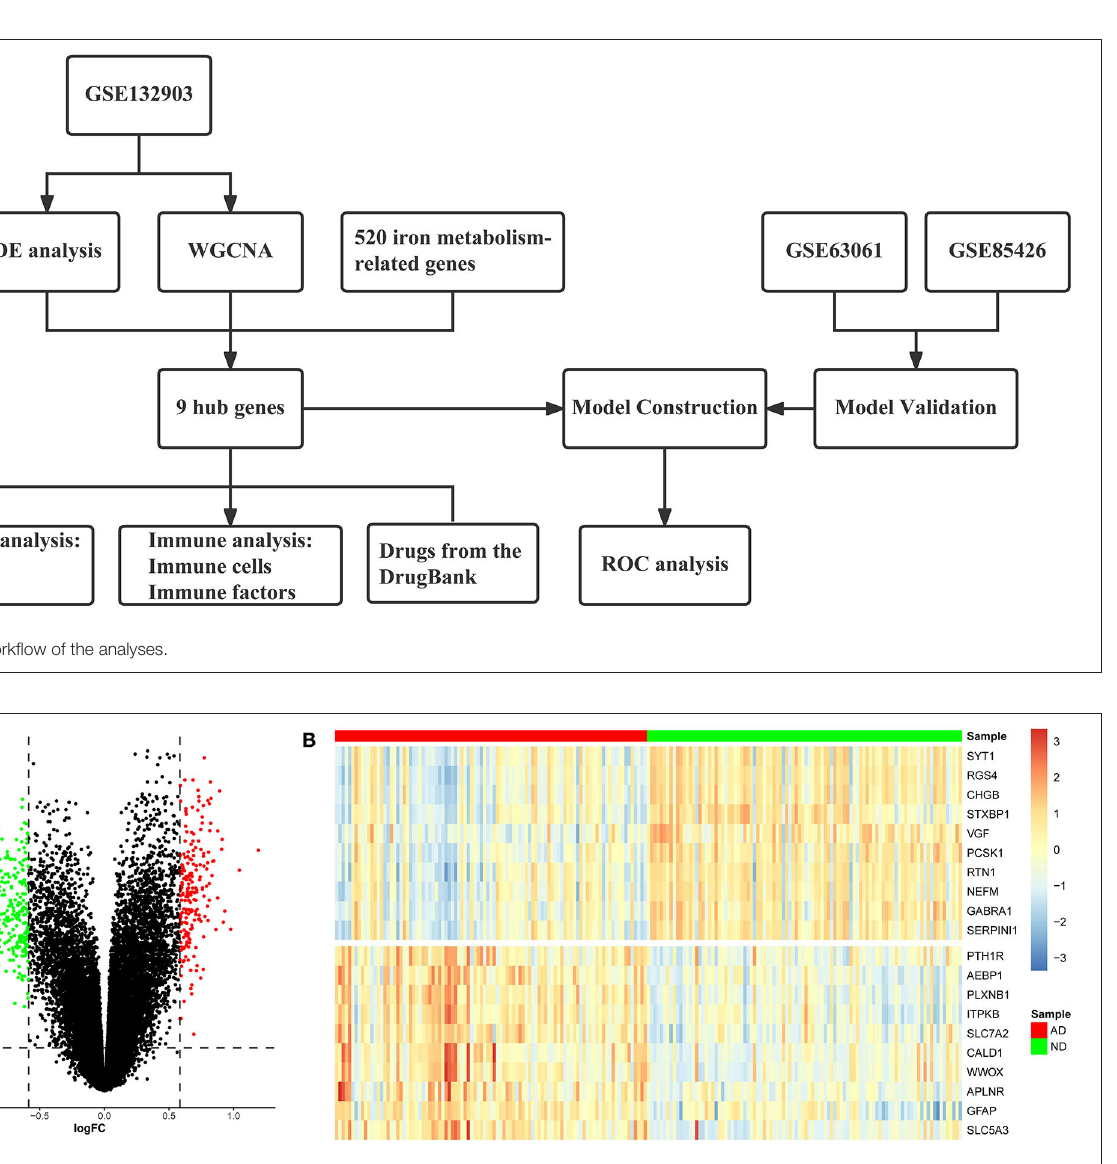
FIGURE 2 | Differentially expressed genes between AD and ND samples. (A) Red genes represent significantly high expression in AD, green genes represent significantly high expression in ND, and gray genes indicate insignificant changes. (B) The heatmap shows the top 20 genes significantly highly expressed in AD or ND